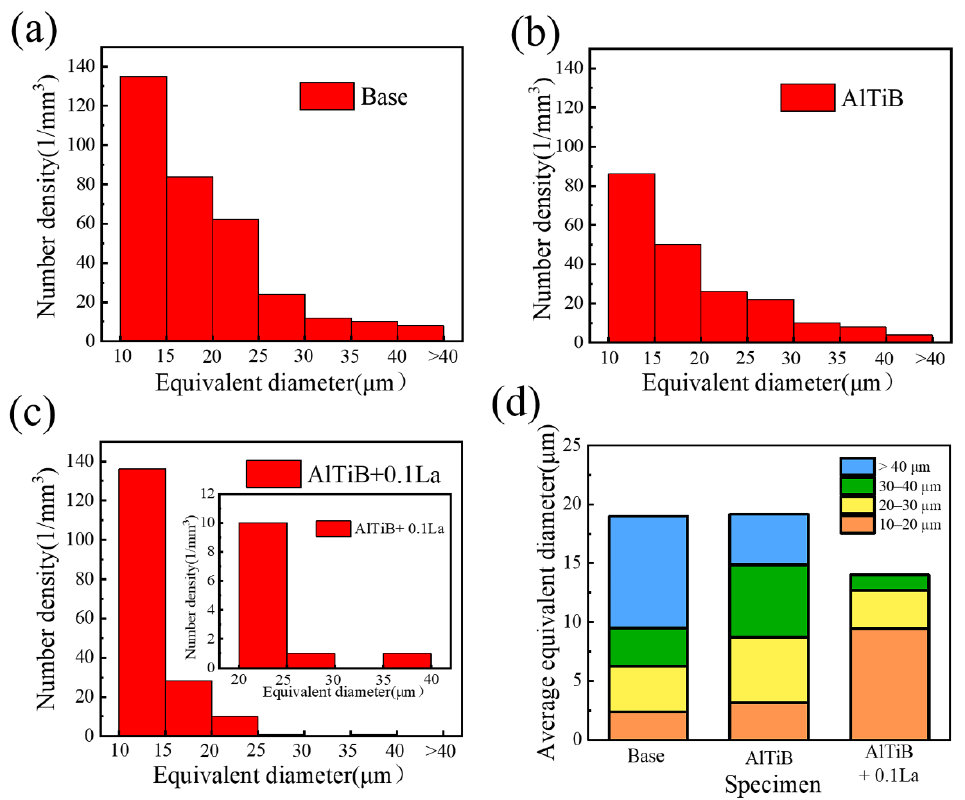
Figure 12. ( a – c ) Histogram of the equivalent diameter distribution of the morphology in the three alloys and ( d ) Average equivalent diameter and contribution of micropores to volume for different size ranges.